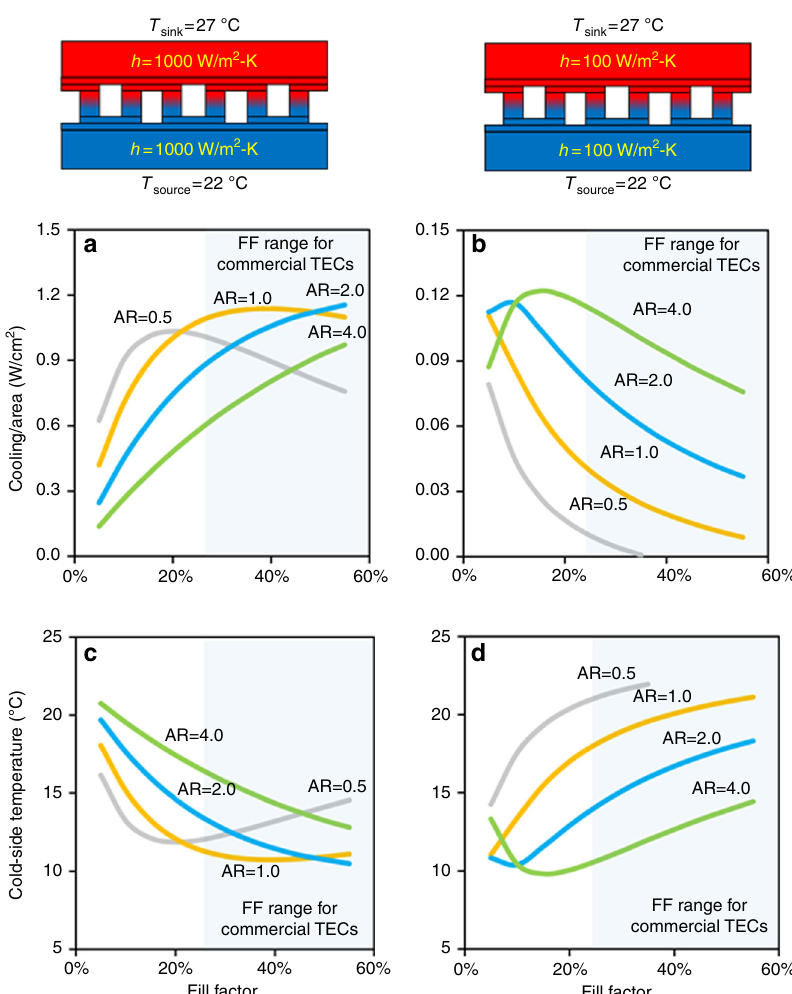
Fig. 3 The effect of resistive environment on the optimal design of TECs. The optimal fi ll factor (FF) and aspect ratio (AR) are strongly affected by heat source and sink resistances. a When heat source and sink resistances are low ( h = 1000 W m − 2 K − 1 ), the optimal FF is more than 20%. b When heat source and sink resistances are high ( h = 100 W − 2 K − 1 ), the optimal FF is less than 20%. c , d The variation in cold-side temperature with variation in FF and AR follows the same trend as cooling